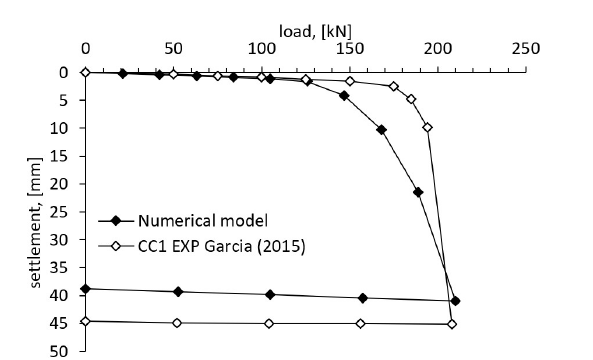
Figure 5. Load-settlement curves of the piled rafts by Garcia [9] versus numerical model.